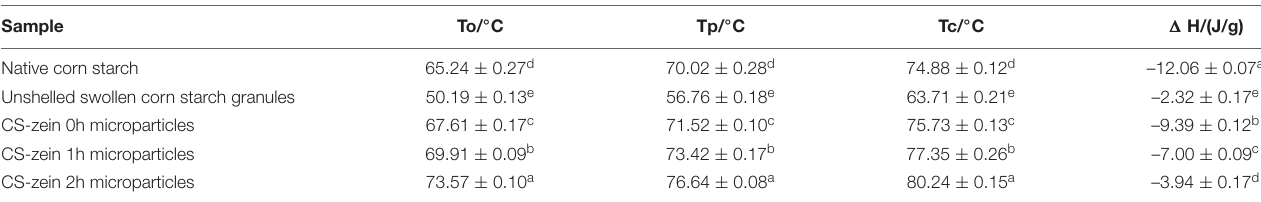
Values indicate means ± SD of three replicates. Data in the same column with different letters are substantially different (p < 0.05).